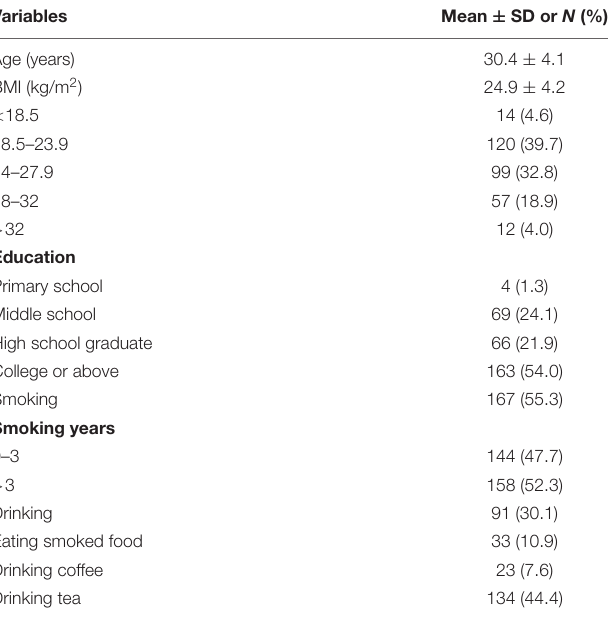
TABLE 2 | Profiles of the 302 male participants in this study.